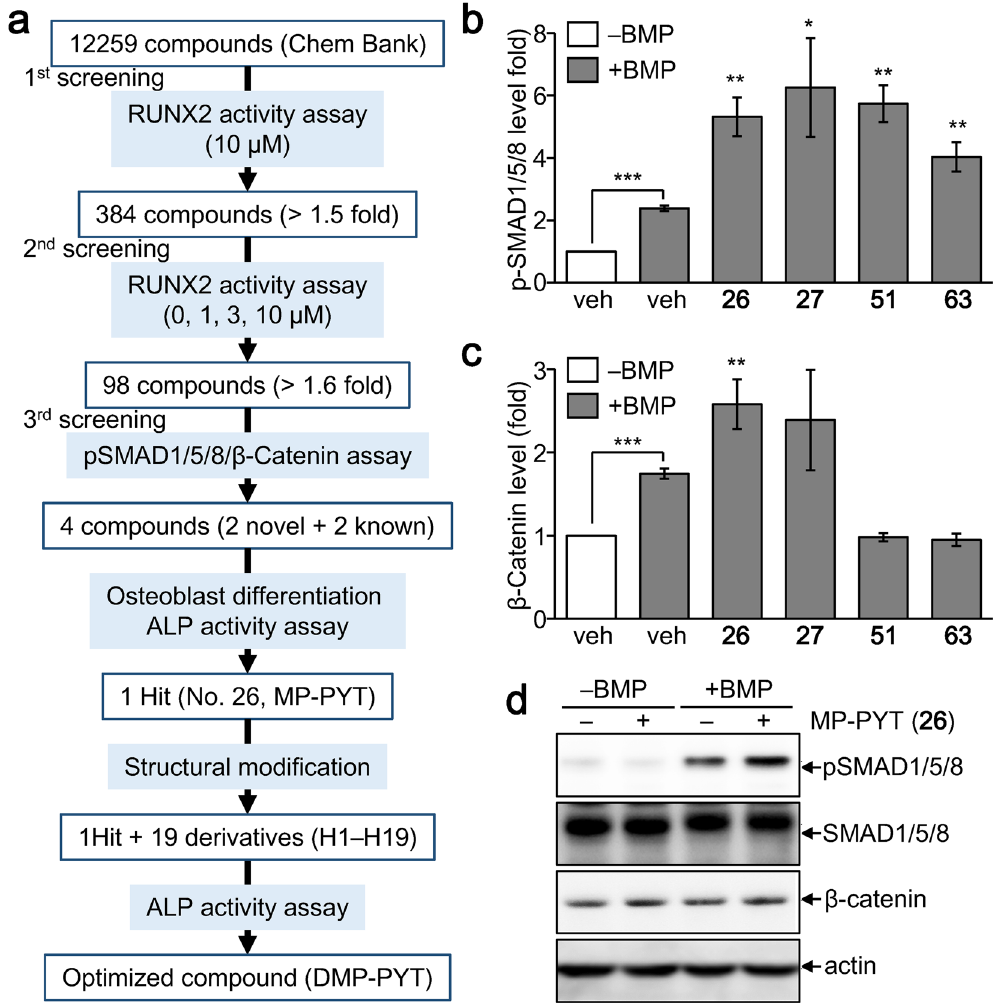
Figure 1. Isolation of novel osteogenic compounds. ( a ) A selection cascade used for isolation of osteogenic compounds from the chemical library (Korea Chemical Bank, http://www.chembank.org). Bioactive compounds were narrowed down through the sequential selection from RUNX2 activity assay, SMAD phosphorylation (pSMADs) assay, β -catenin expression assay, ALP activity assay, and ALP staining after osteoblast differentiation. ( b , c ) Confluent C2C12 cells were treated with a 10 µ M of the selected compounds ( 26 , 27 , 51 , and 63 ) in the presence of BMP2 (25 ng/ml) for 30 min and subjected to immunoblotting of pSMADs and β -catenin, followed by protein extraction. Quantitation of pSMADs ( b ) and β -catenin ( c ) band intensity was determined from three independent experiments by densitometry using Image J software. The averages of expression level of pSMADs ( b ) and β -catenin ( c ) are shown. * P < 0.05, ** P < 0.005, and *** P < 0.0005. ( d ) Confluent C2C12 cells were treated with MP-PYT ( 26 ) in the absence or presence of BMP2 (25 ng/ml) for 30 min and collected for immunoblotting analysis with antibodies against pSMAD1/5/8, SMAD1/5/8, β -catenin, and β